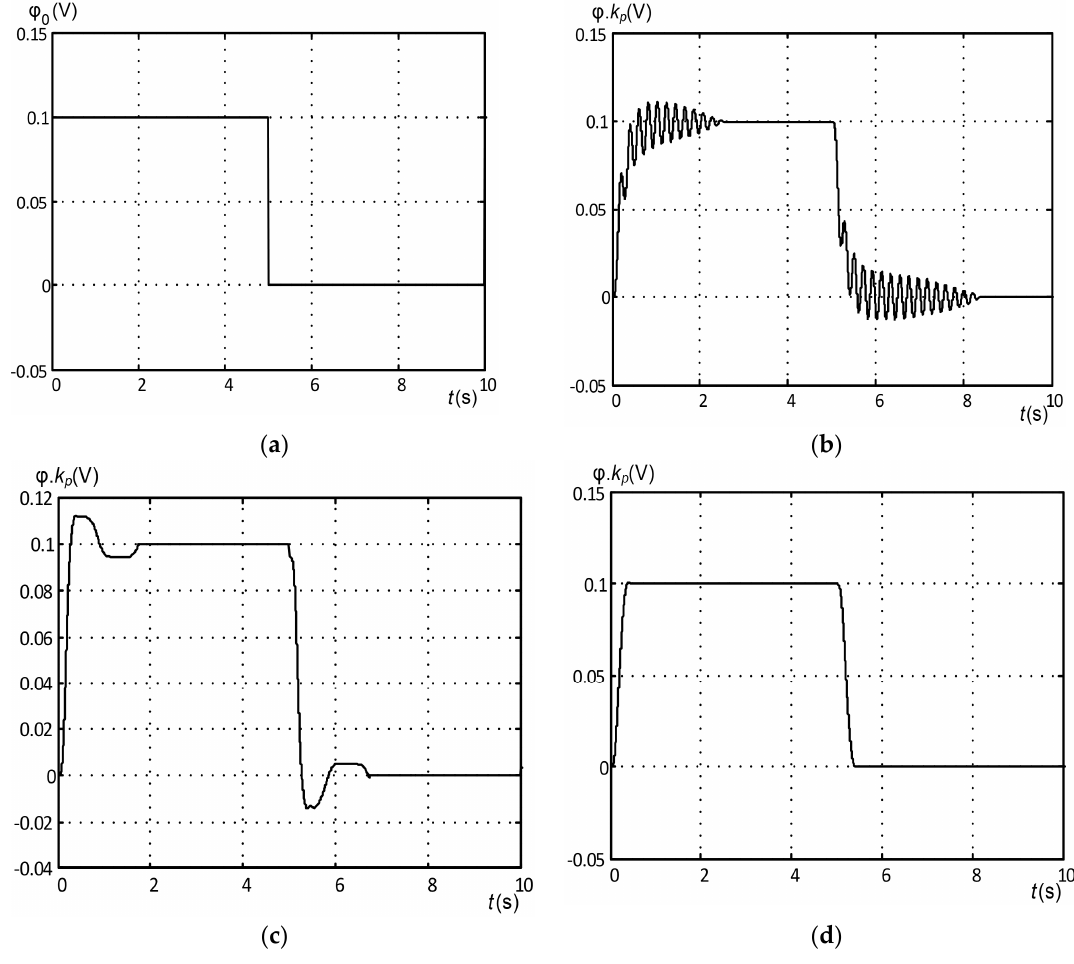
Figure 6. The experimental results: ( a ) the desired position signal; ( b ) The output signal of the control object without the controller; ( c ) the output signal of the control object when using the modal controller; ( d ) the output signal graph of the control object when using an adaptive controller for the major functions.